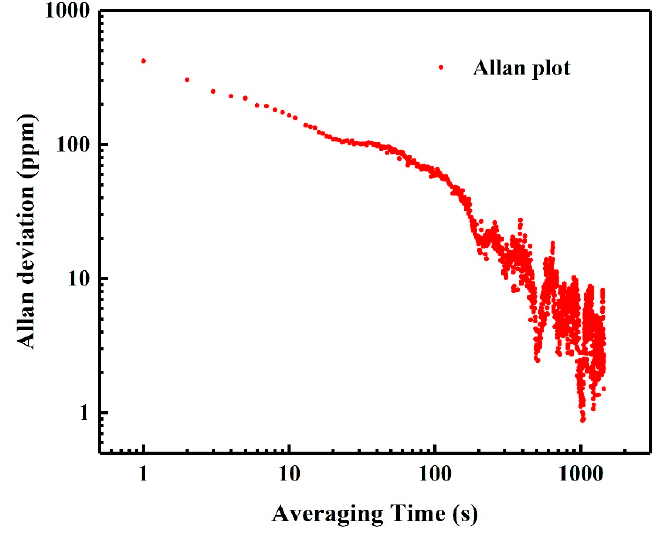
Figure 8. Allan–Werle deviation plot of the QEPAS based sensor system at different averaging time.